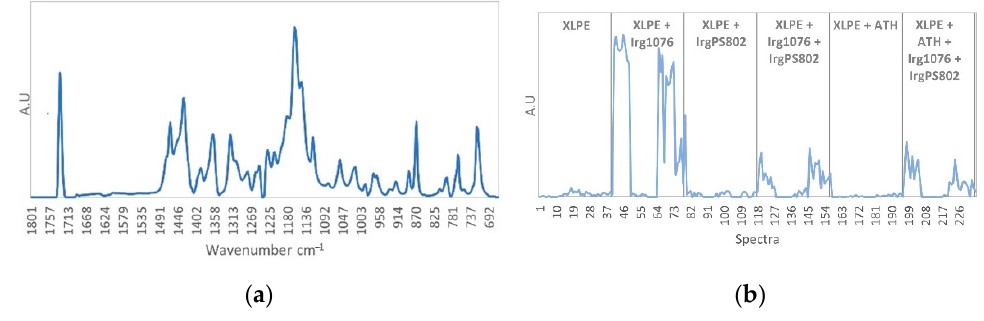
Figure 14. ( a ) Irg1076 pure spectrum. ( b ) Irg1076 concentration profile.